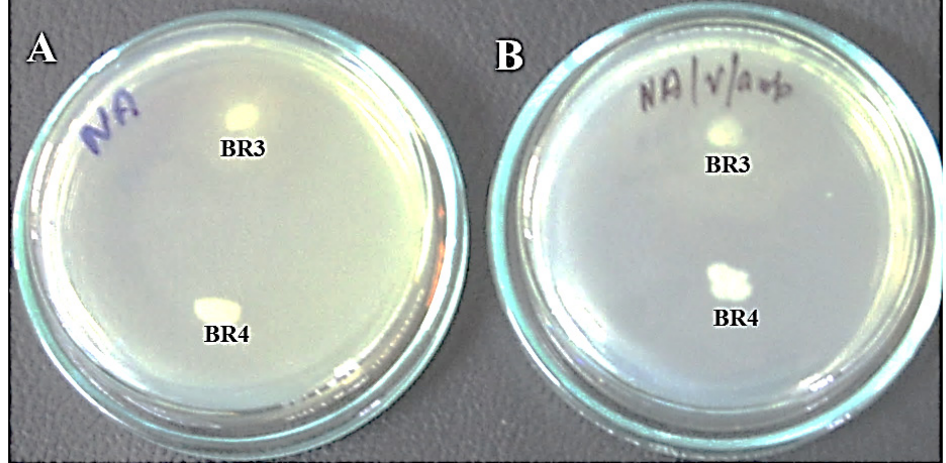
Figure 2. Growth of isolates BR3 and BR4 on nutrient agar plates. ( A ) Nutrient agar plate without ampicillin. ( B ) Nutrient agar plate with ampicillin.